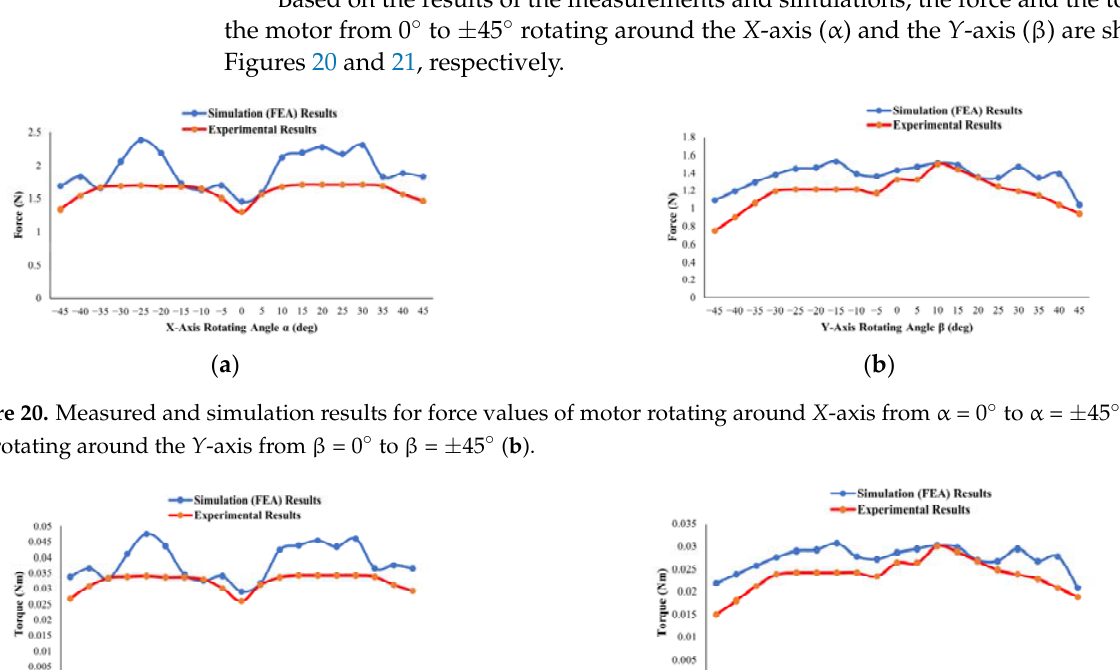
Figure 20. Measured and simulation results for force values of motor rotating around X ‐ axis from α = 0° to α = ±45° ( a ) and rotating around the Y ‐ axis from β = 0° to β = ±45° ( b ). Figure 21. Measured and simulation results for the torque values of the motor rotating around the X ‐ axis from α = 0° to α = ±45° ( a ) rotating around the Y ‐ axis from β = 0° to β = ±45° ( b ).